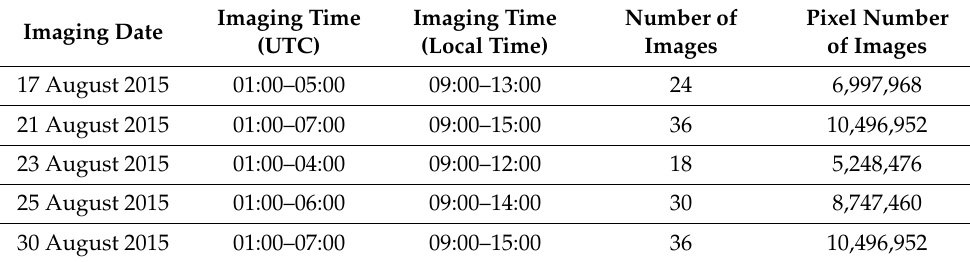
Table 1. The Himawari-8 Level 1 full-disk data used in the study.